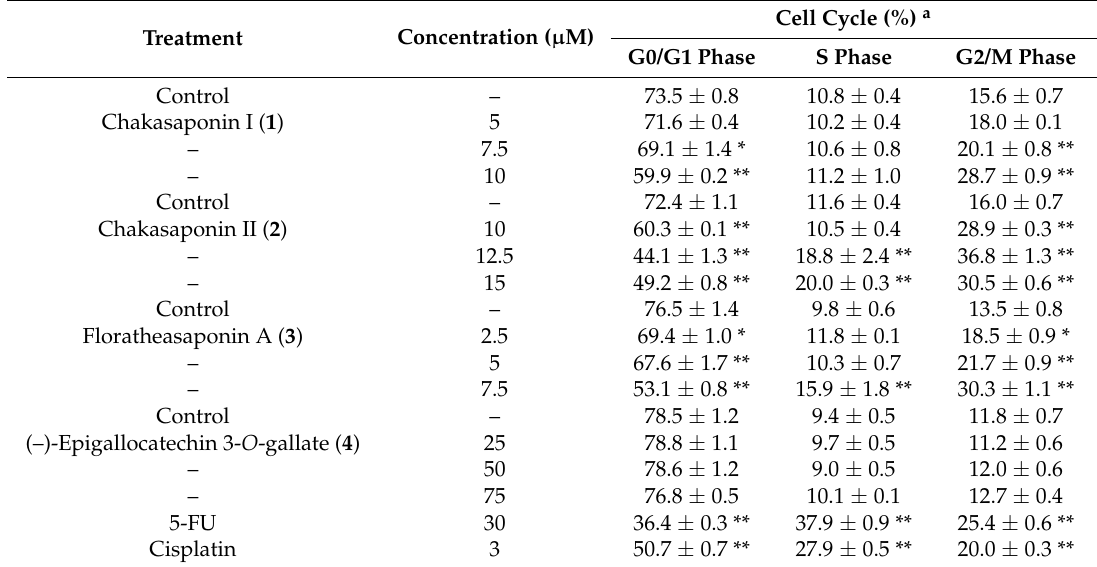
Table 2. Effects of 1 – 4 , 5-FU, and cisplatin on cell cycle distribution of HSC-2 cells for 48